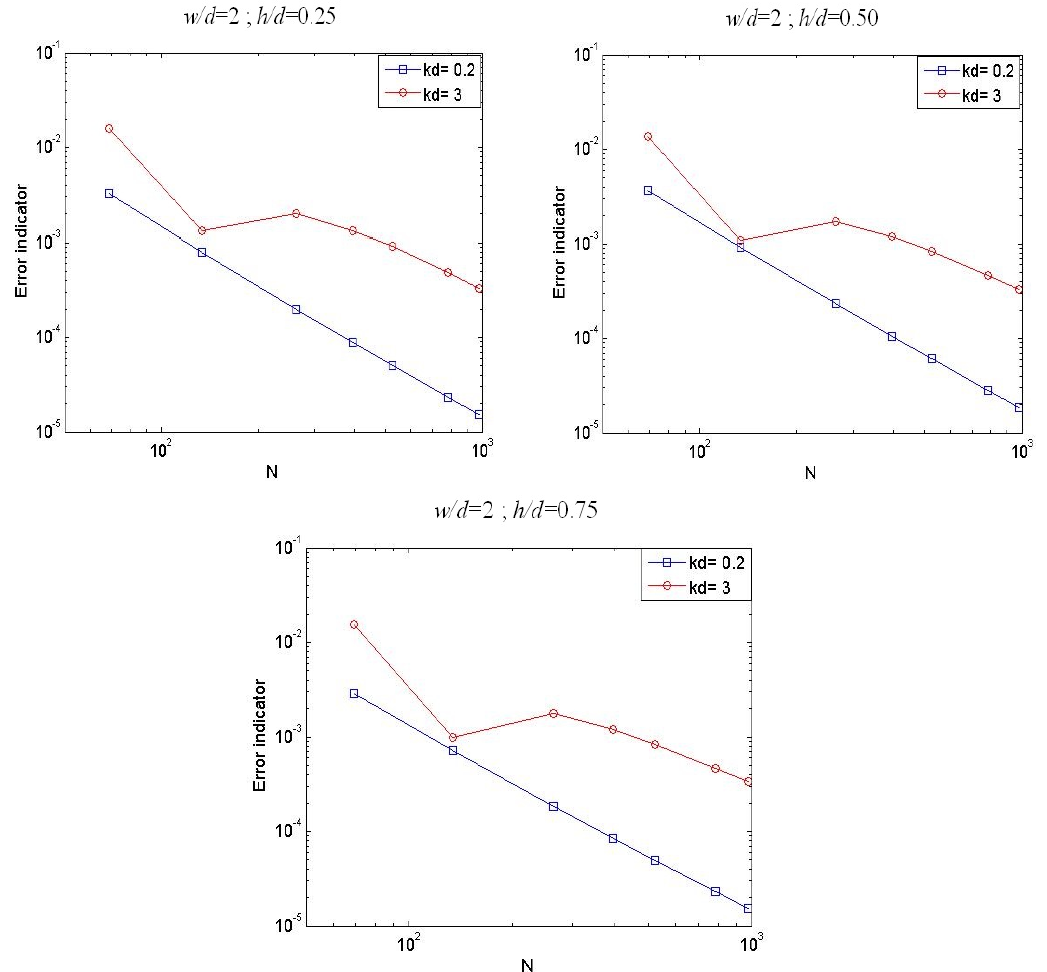
Figure 4. Error indicator versus the number of boundary nodes for different immersion ratios.